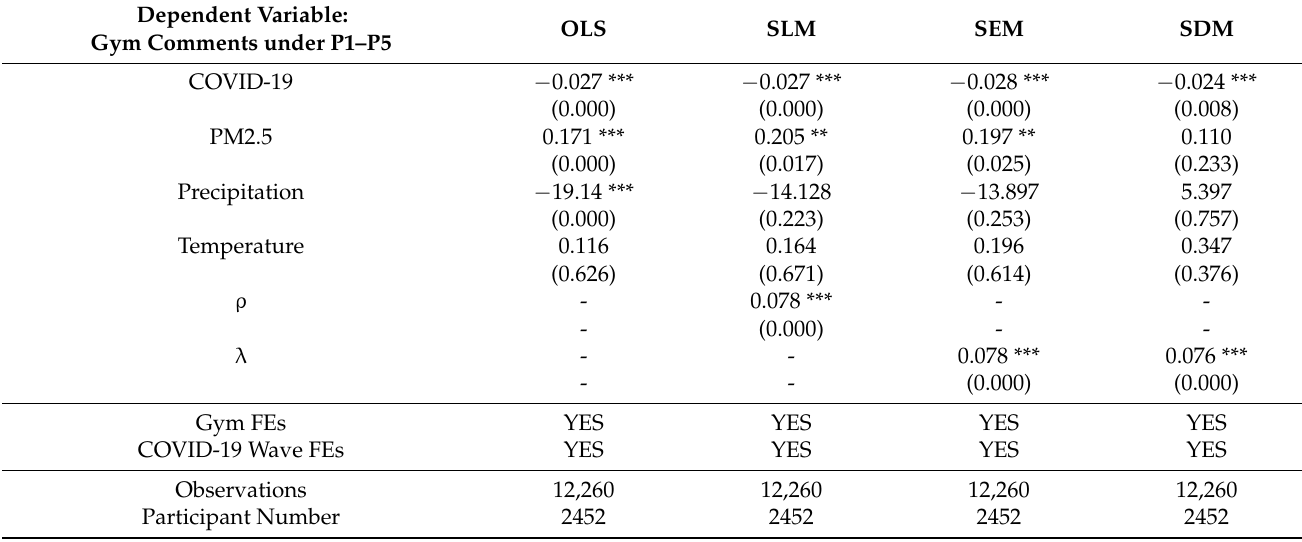
Table 7. Four regression model results in